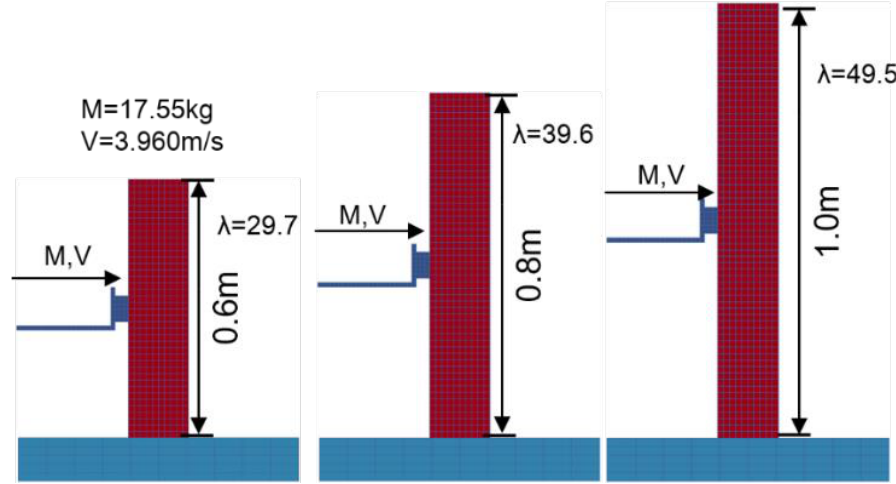
Figure 23. Finite element model of columns with different slenderness ratios.